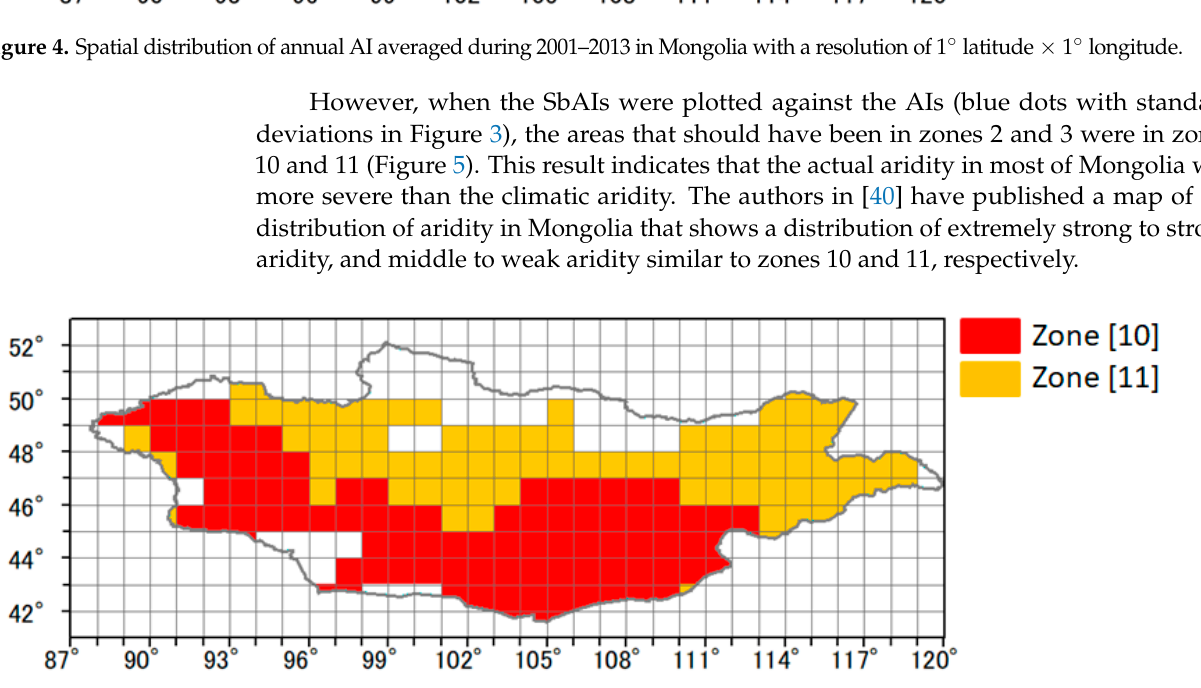
Figure 5. Spatial distribution of dry zone categories 10 and 11 during 2001–2013 in Mongolia with a resolution of 1° latitude × 1° longitude.